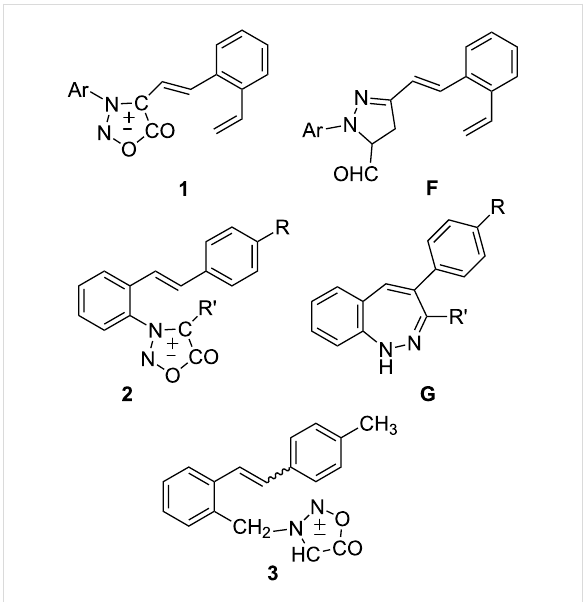
Figure 3: Styryl-sydnone 1 and stilbenyl sydnone 2 and their photo- products F and G , respectively; target molecules 3 in this work.